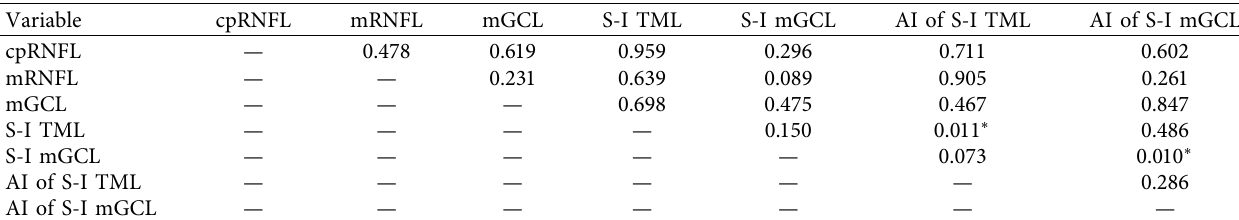
Table 4: Comparison of areas under the receiver operating characteristic curves for circumpapillary retinal nerve fiber layer thickness, macular retinal nerve fiber layer thickness, macular ganglion cell layer thickness, thickness difference of total macular layer, thickness difference of macular ganglion cell layer, asymmetry index of total macular layer, and asymmetry index of the macular ganglion cell layer. Variable